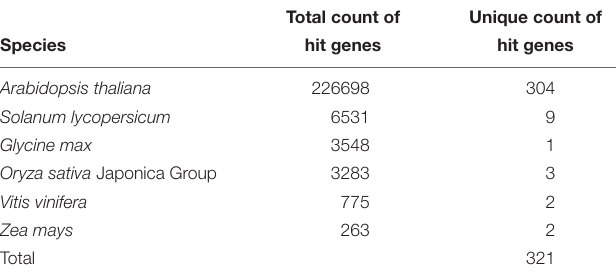
TABLE 1 | Plants species with stomata-related proteins in PaperBLAST